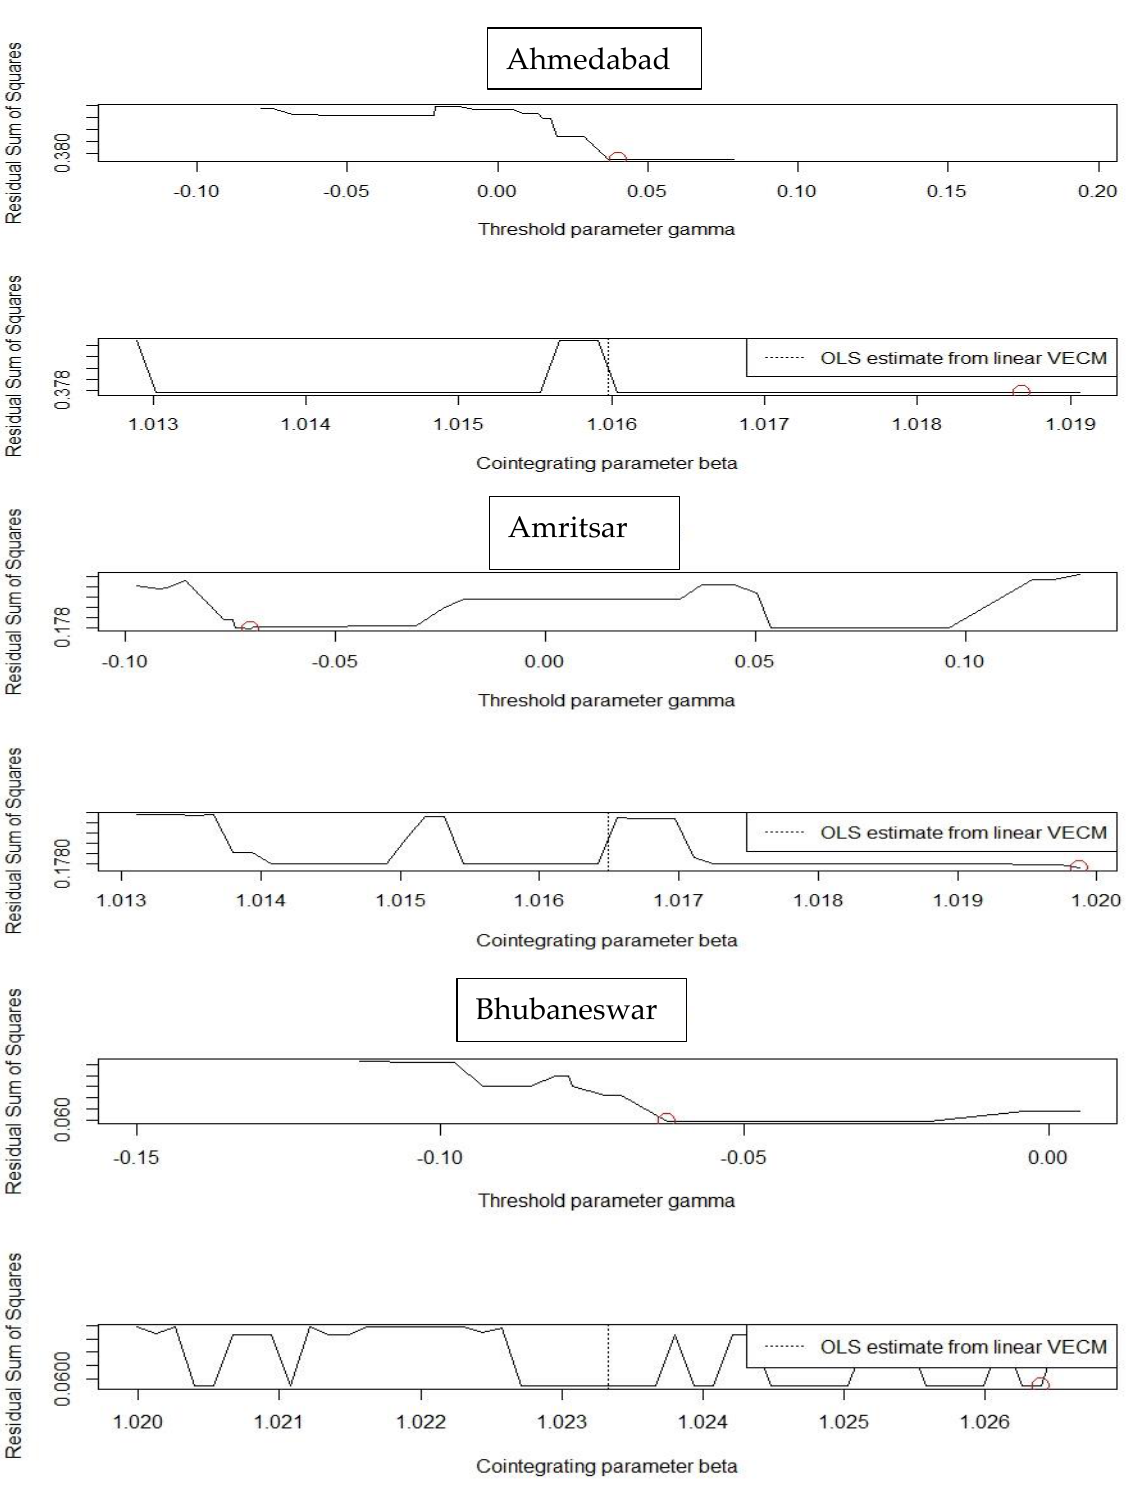
Figure 1. Grid search to find the optimum value of the threshold parameter and cointegration parameter in TVECM.